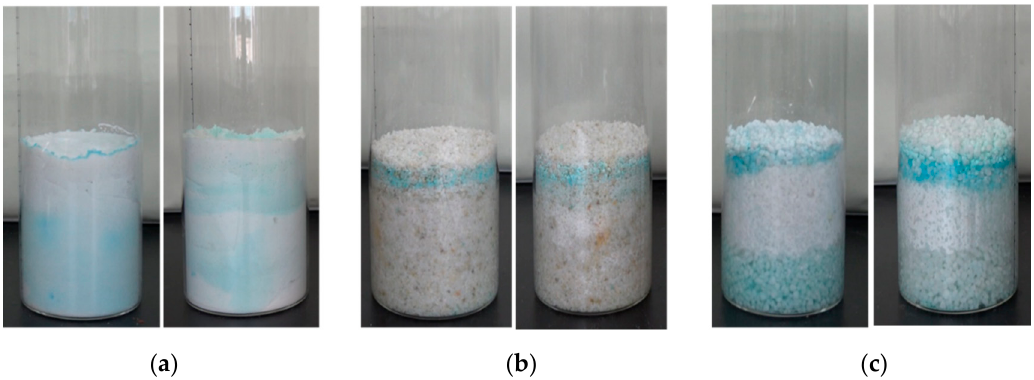
Figure 8. State of salt-containing samples after 1 and 3 humidification–drying cycles. ( a ) B3; ( b ) C3; ( c )